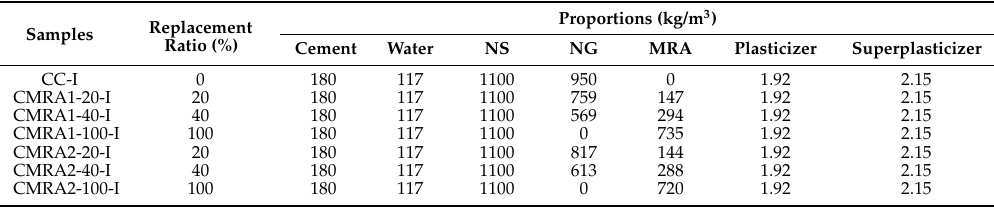
Table 4. Composition of the concrete mixes for Series I (180 kg of cement/m 3 ). CC: Control concrete. Samples